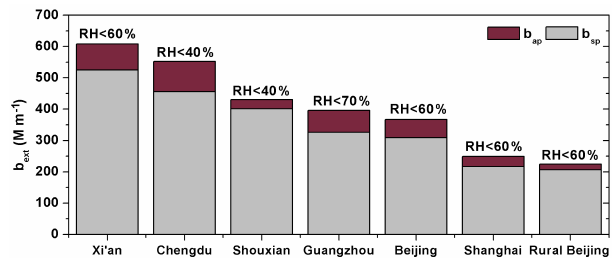
Figure 12. Annual b sp and b ap in